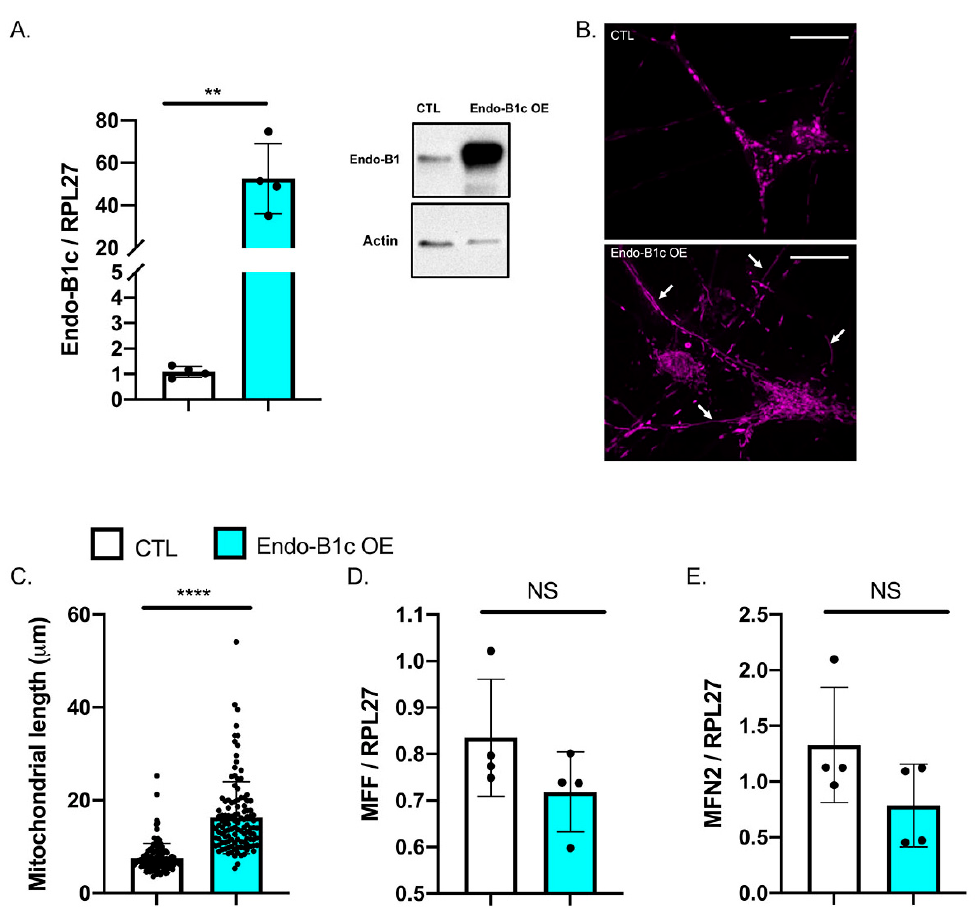
Figure 5. Overexpression (OE) of Endophilin-B1c in hiPSC-derived neurons leads to elongated mitochondria but does not influence MFN2/MFF gene expression. ( A ). mRNA quantification of Endo-B1c OE compared to a control OE vector (Each dot represents the mean of 4 independent experiments, ** p < 0.01 by t -test). Representative Western blot confirms overexpression of Endo-B1c protein. ( B ). Representative image of elongated mitochondria visualized with MitoTracker in hiPSC-derived neurons with Endo-B1c OE vs. a control overexpression vector. ( C ). Quantification of mitochondrial length in neurites ( N = 4 independent MitoTracker experiments, 59 control mitochondria, and 62 Endo-B1c OE mitochondria, **** p < 0.0001 by Mann–Whitney U test). ( D , E ). qRT-PCR analysis of MFF ( D ) and MFN2 ( E ) expression in Endo-B1c overexpressing neurons (Each dot represents the mean of 4 independent experiments, NS = not significant by t -test). Scale bar = 20 μ m.